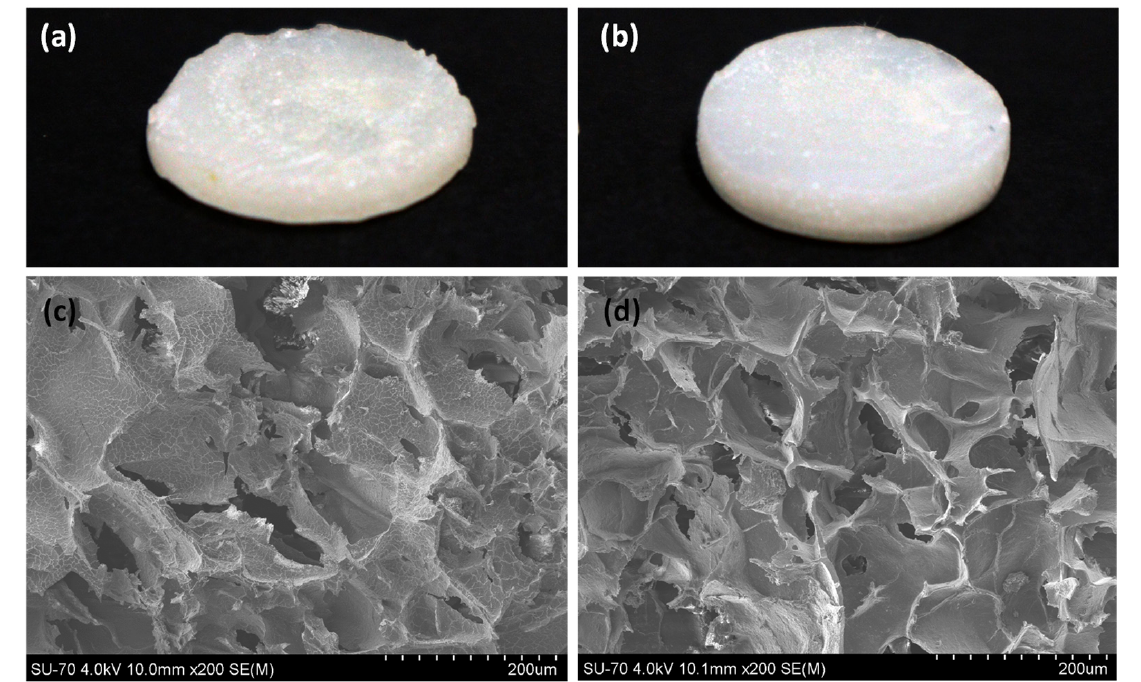
Figure 5. ( a , b ) Visual aspect of alginate-based hydrogels with ( a ) ibuprofen (Alg-Ibu) and ( b ) with DES aqueous solutions comprising ibuprofen (Alg-(DES + Ibu)) and ( c , d ) the corresponding cross- section SEM micrographs.